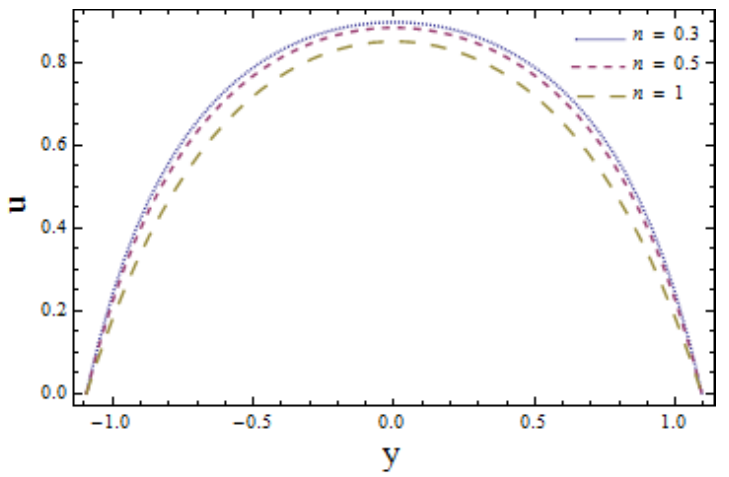
Figure 4. Velocity u versus y with n when (cid:101) = 0.1, x = 0.2, t = 0.01, E 1 = 0.4, E 2 = 0.2, E 3 = 0.3, m = 0.04, We = 0.03 and m 1 = 2.